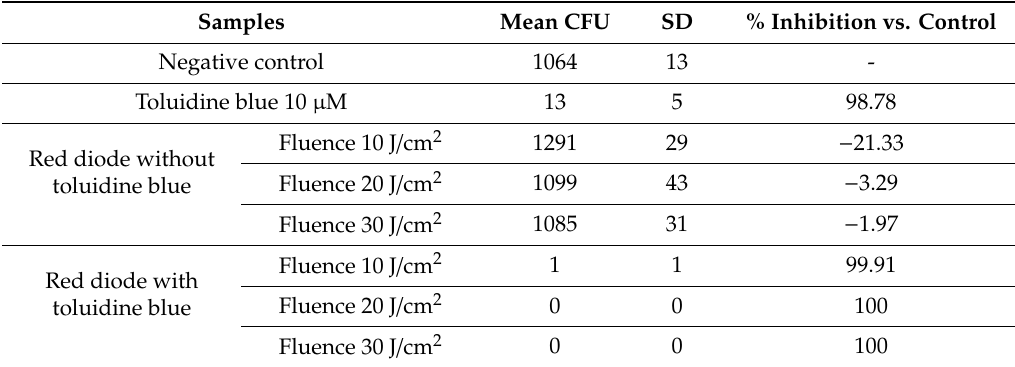
Table 1. E ff ect of red laser (650 nm) application on bacterial suspensions with and without toluidine